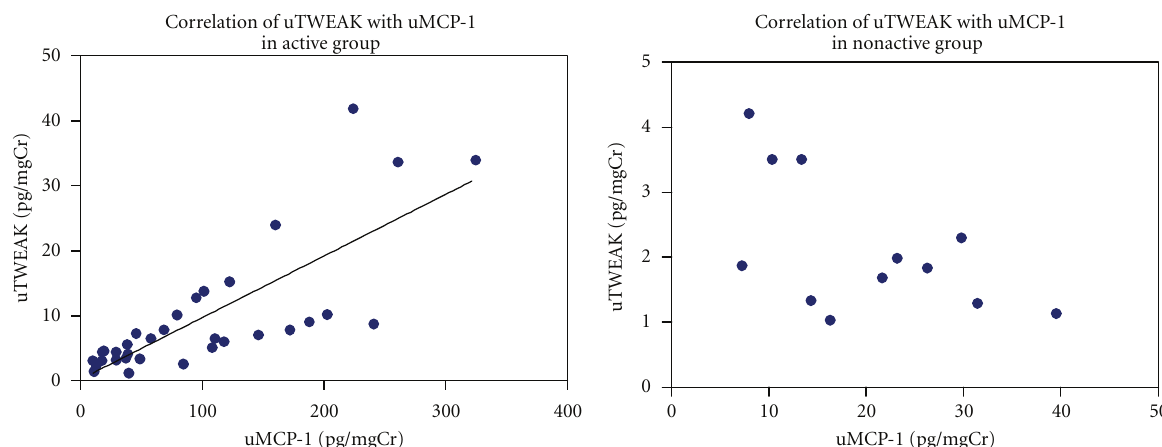
Figure 5: uTWEAK correlated with uMCP-1. Urinary TWEAK levels of 34 patient with active LN had significantly positive correlation with urinary MCP-1 levels, r = 0 . 809, P < 0 . 01. In disease nonactive group, 12 patients’ urinary TWEAK levels had no correlation with their urinary MCP-1